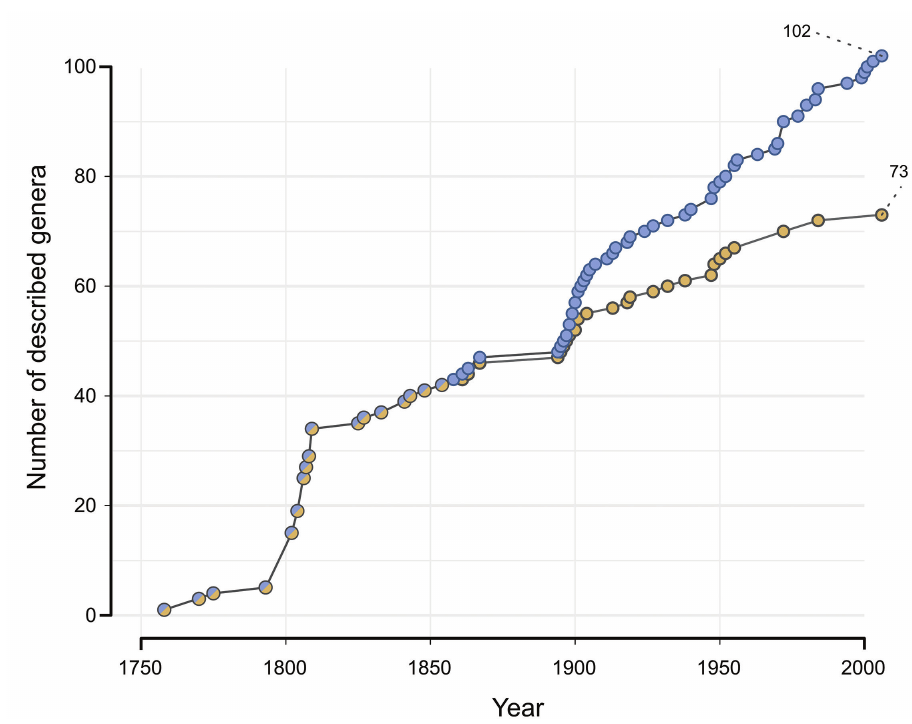
Figure 1. Cumulative number of valid bee genera by year of description for Europe (as defined by Rasmont et al. 2017) (yellow dots) and the wider West Palaearctic region (blue dots). The recognition of genera follows Rasmont et al. (2017) with modifications as defined in the